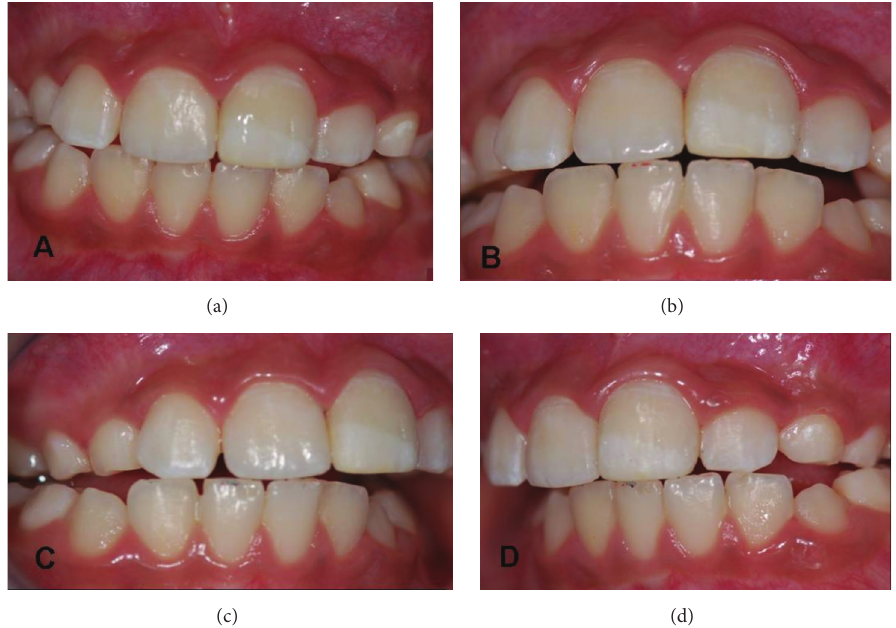
Figure 9: (a) Clinical aspect of the restoration after removal of the absolute isolation. (b) Clinical aspect in protrusion. (c) and (d) Clinical aspects in